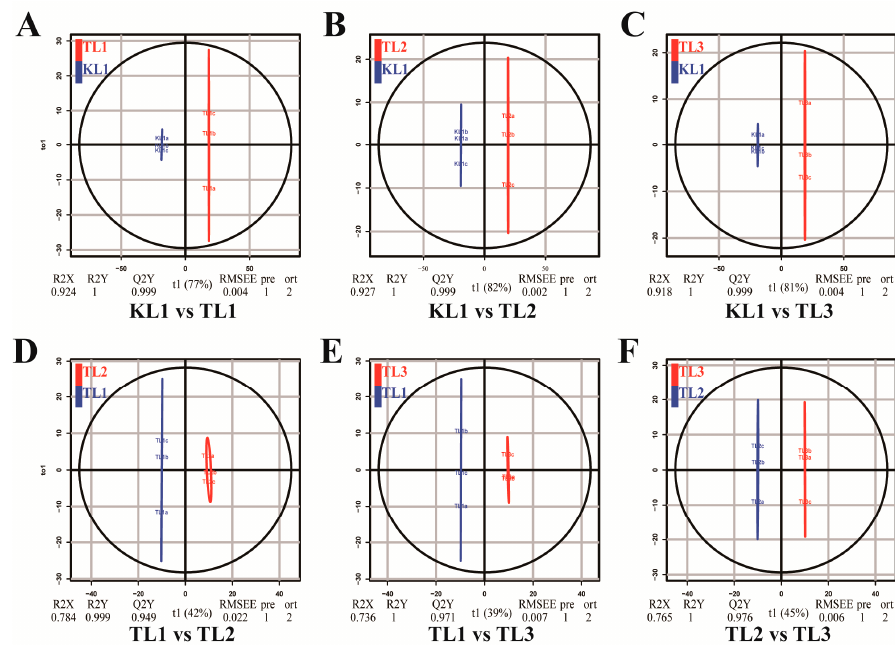
Figure 4. Differential flavonoid metabolite analysis on the basis of orthogonal signal correction and partial least squares-discriminant analysis (OPLS-DA). ( A – F ) OPLS-DA model plots for the comparison group KL1 vs. TL1, KL1 vs. TL2, KL1 vs. TL3, TL1 vs. TL2, TL1 vs. TL3, and TL2 vs. TL3, respectively.